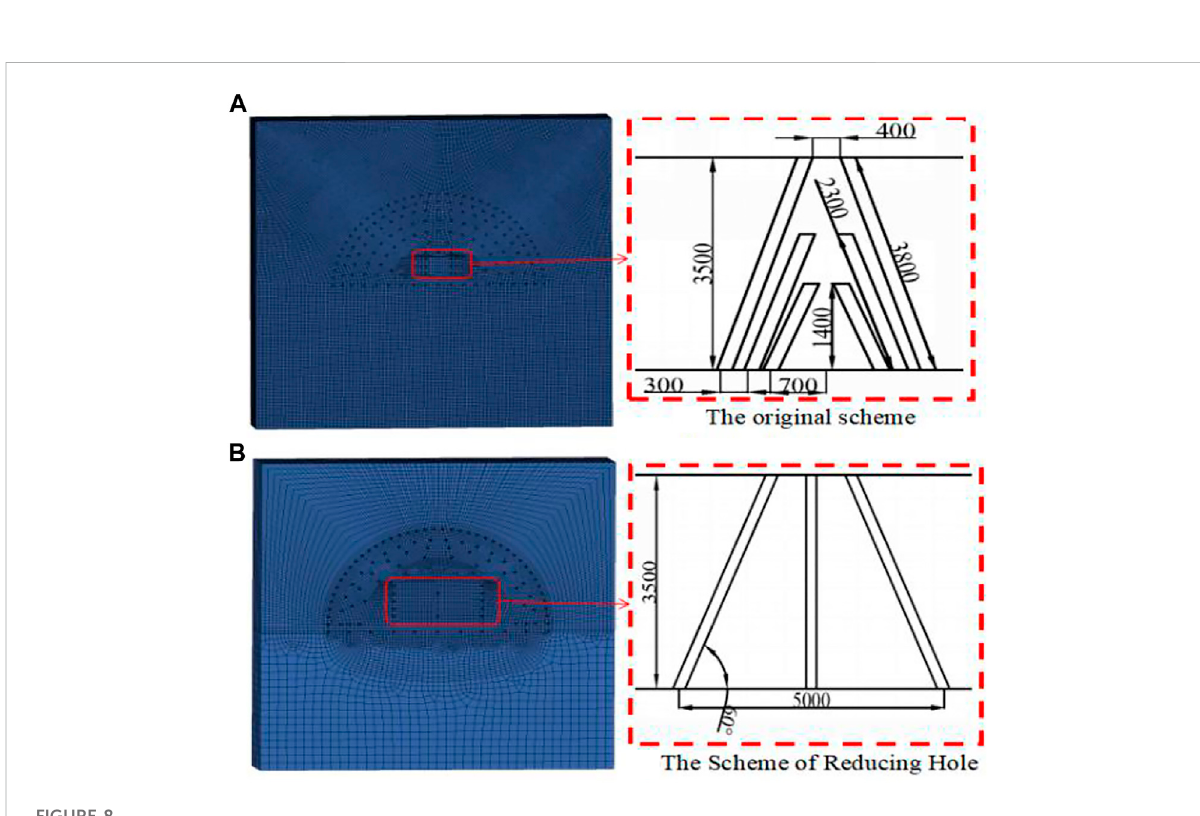
FIGURE 8 Schematic diagram of the two